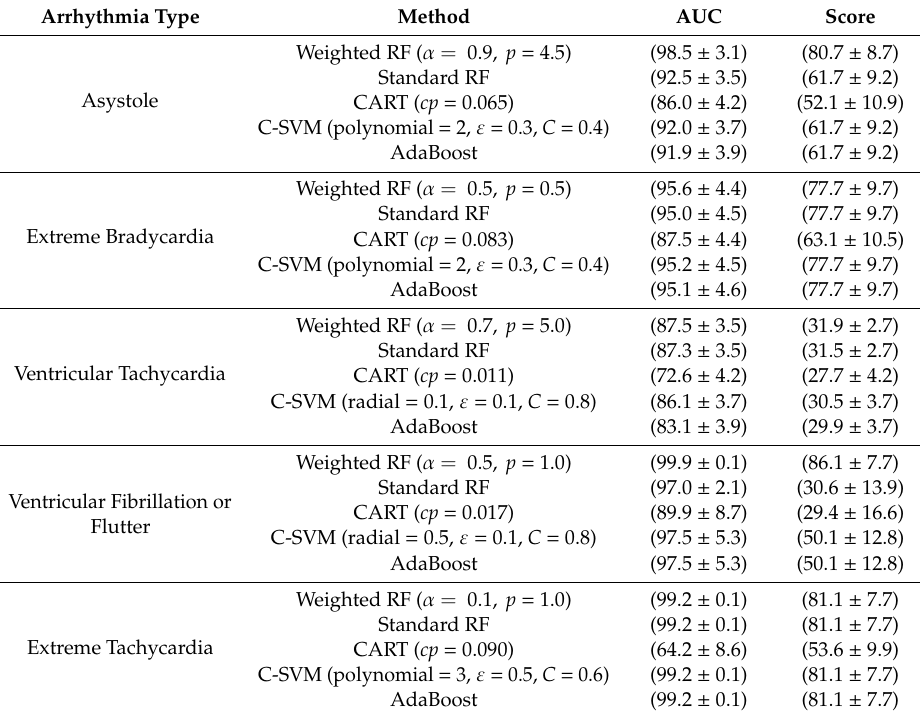
Table 9. Detailed classification results for benchmarking